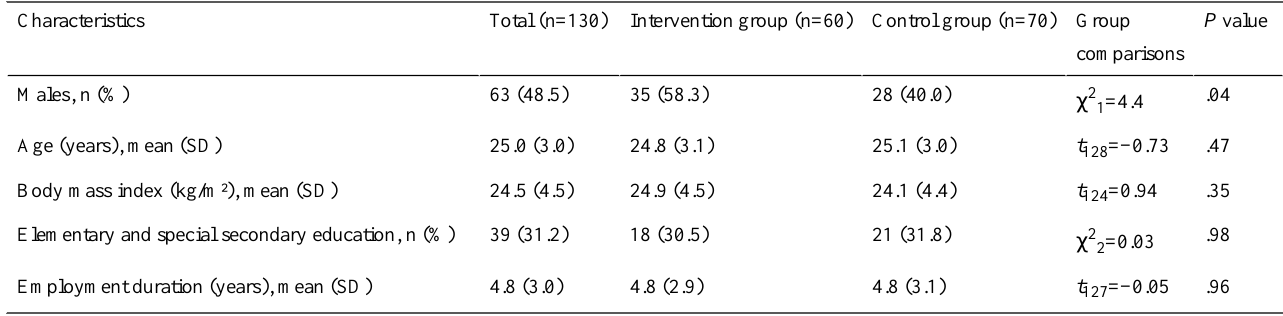
Table 2. Descriptive statistics and group differences at